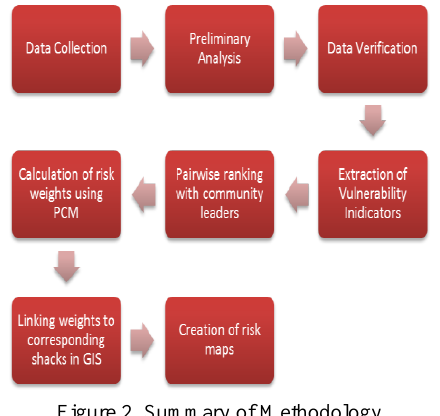
Figure 2. Summary of Methodology